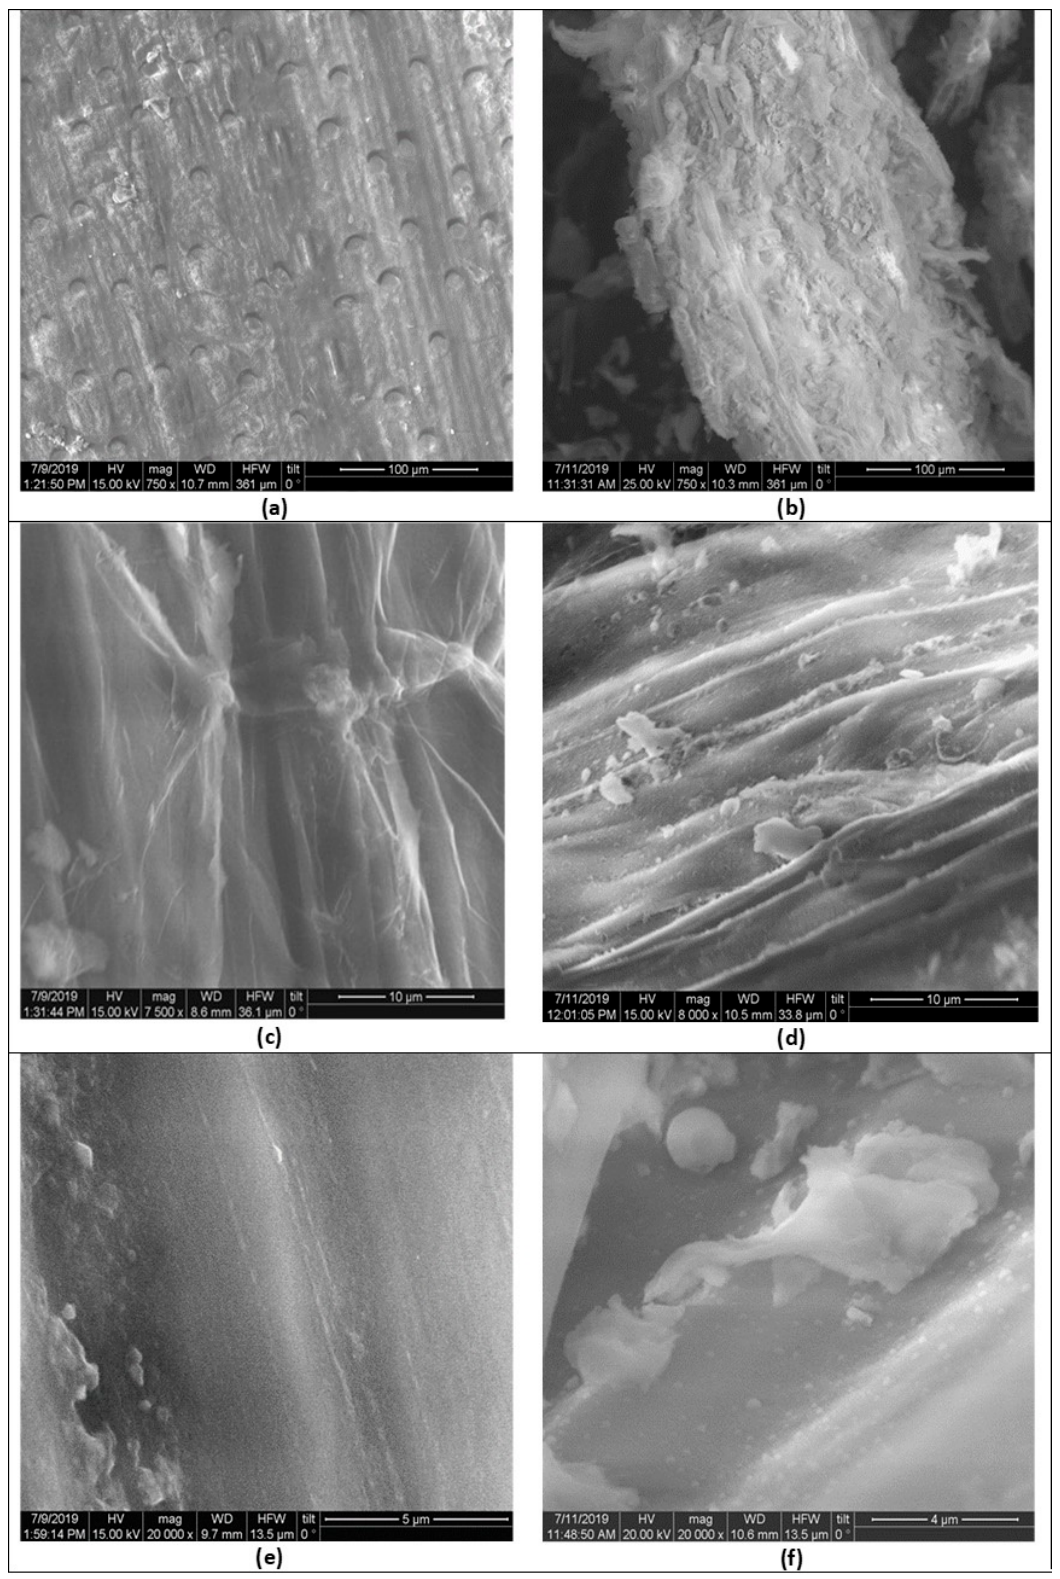
Figure 6. SEM results of original barley straw at ( a ) × 750, ( c ) × 7500 and ( e ) × 20,000 magnification, and ACWT-treated material at ( b ) × 750, ( d ) × 7500 and ( f ) × 20,000 magnification.